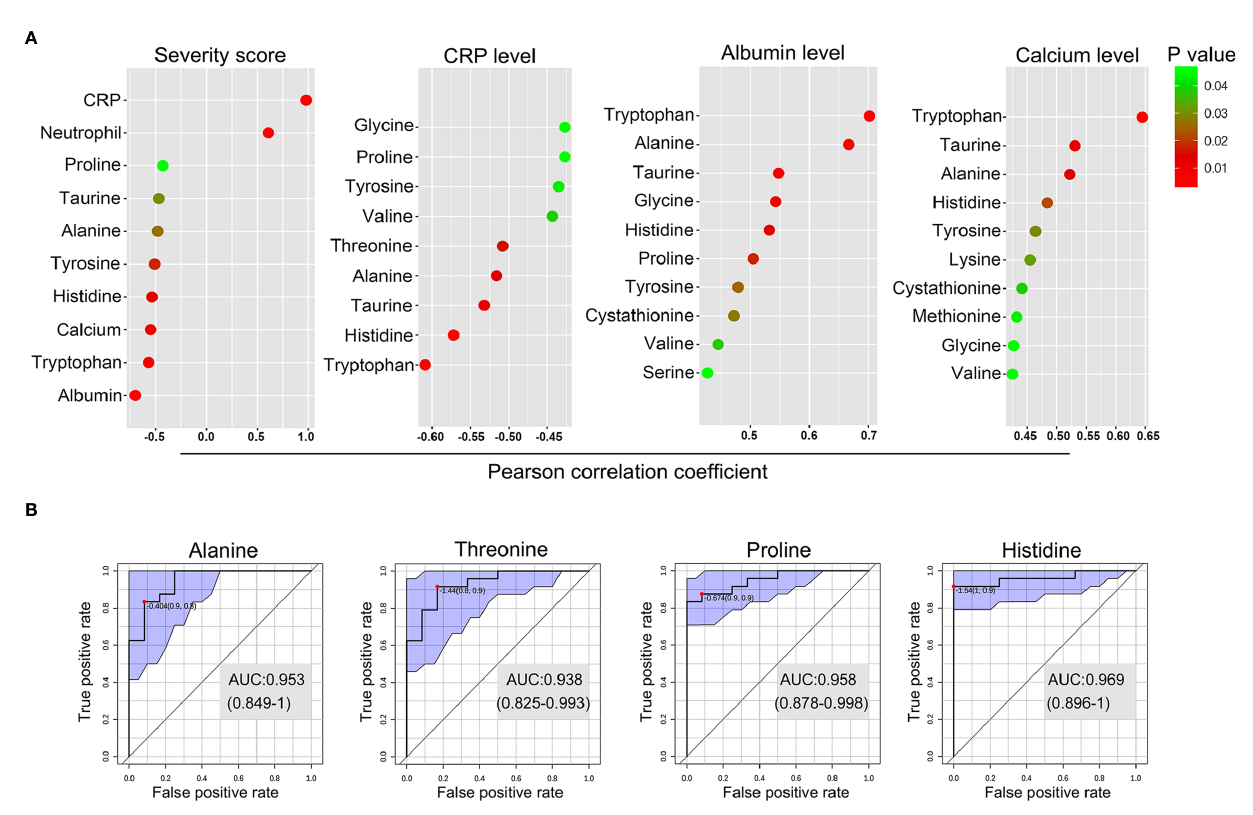
FIGURE 5 | Biomarker analysis of the amino acid in GPP. (A) Pearson partial correlation analysis (adjusted for gender, age and BMI) between 14 amino acids and clinical traits of GPP including JDA severity scores, CRP levels, albumin levels and calcium levels. (B) The performance prediction of metabolites as potential biomarkers is demonstrated as ROC curves. Four metabolites of AUC values higher than 0.9 were